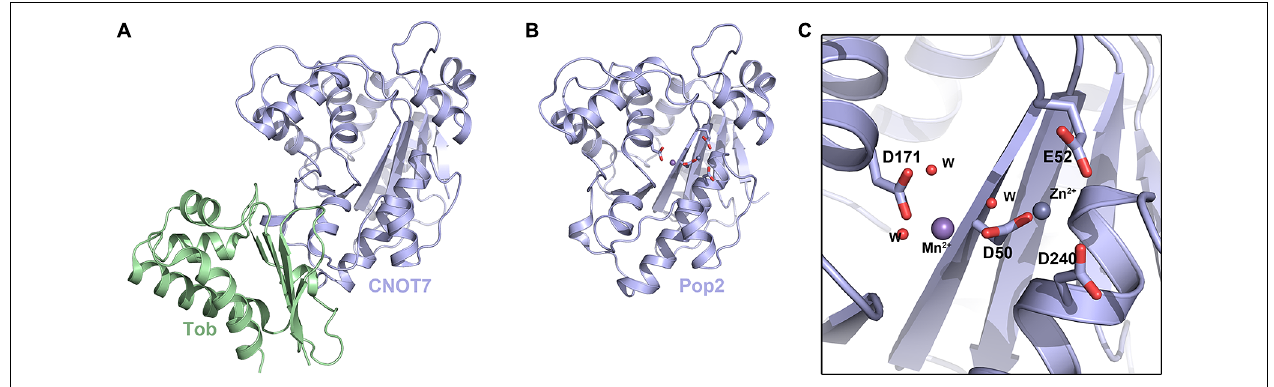
FIGURE 2 |The DEDD-type deadenylases. (A) Crystal structure of the human CNOT7–Tob complex (PDB ID: 2D5R). (B) Crystal structure of S. pombe Caf1 (PDB ID: 3G0Z). (C) Enlarged view of the S. pombe Caf1 active